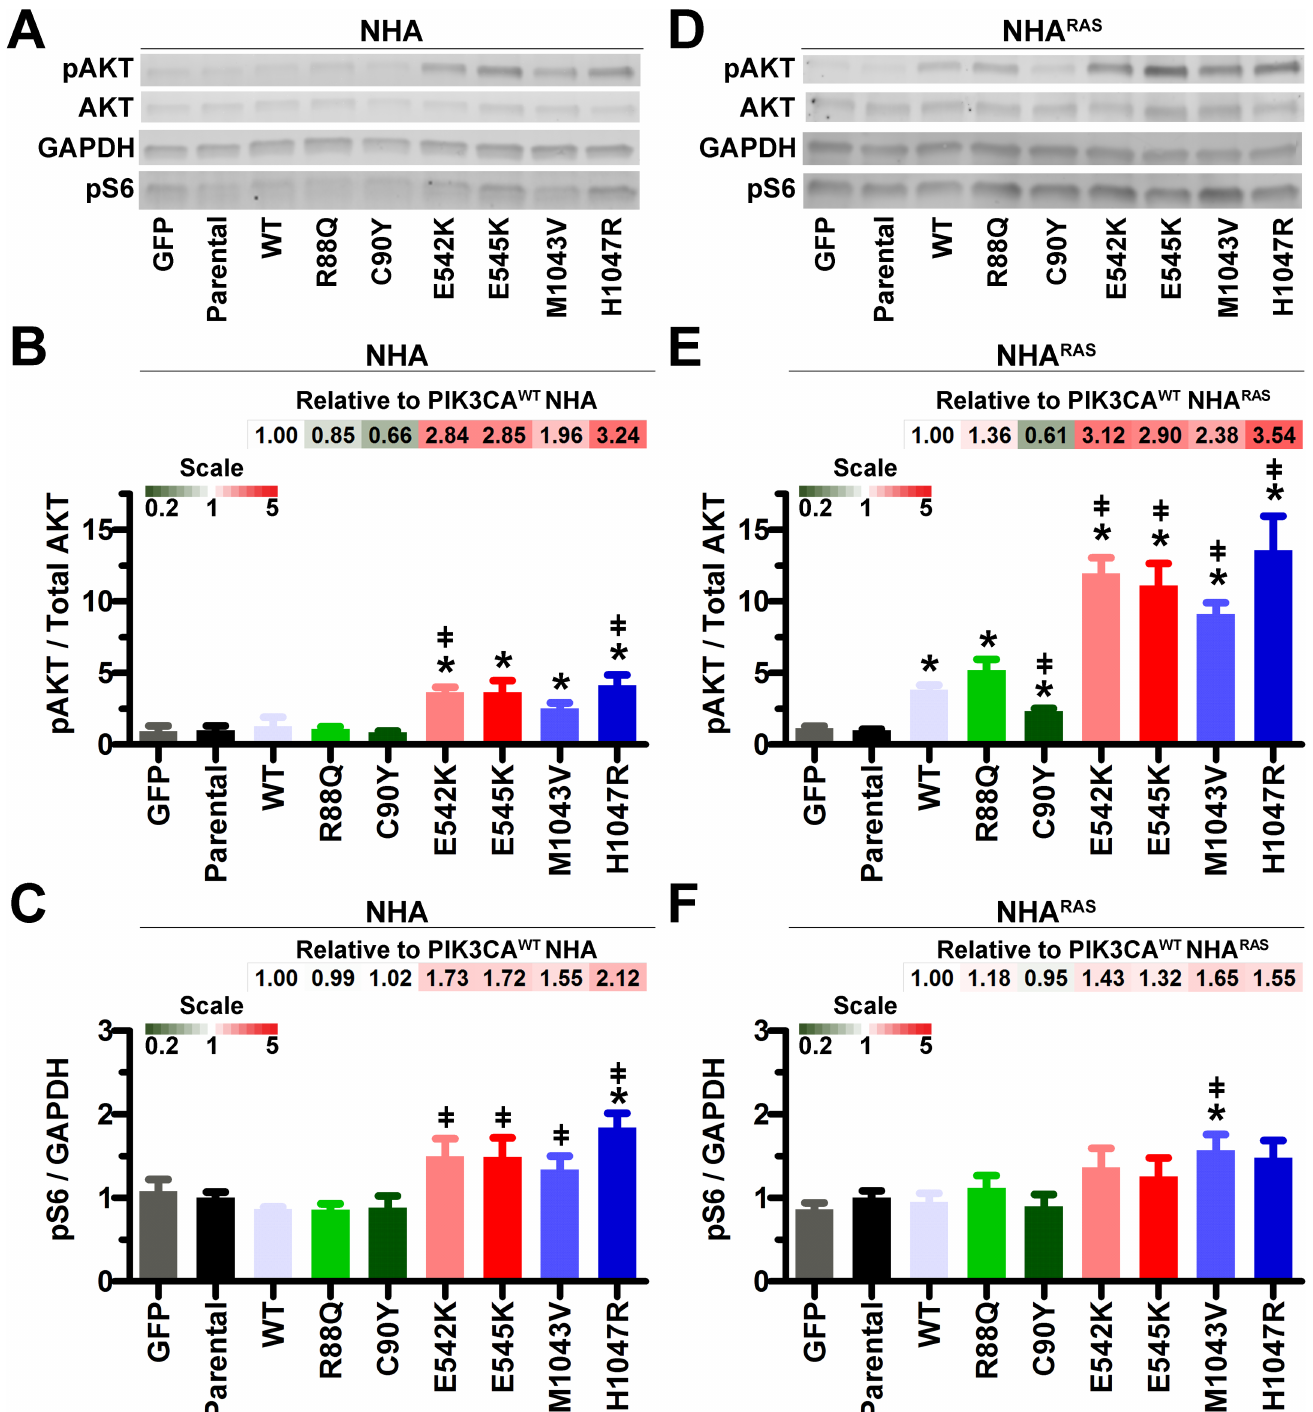
Fig 1. Helical and kinase PIK3CA mut activate proximal PI3K. Representative immunoblots ( A ) and quantification showed that proximal PI3K (pAKT) was increased by helical and kinase mutants in NHA ( B ). Distal PI3K (pS6) was only increased by H1047R ( C ) ( (cid:3) , P (cid:20) 0.02). E542K and H1047R increased proximal PI3K and all helical and kinase mutants increased distal PI3Kcompared to PIK3CA WT NHA (‡, P (cid:20) 0.04). Representative immunoblots ( D ) and quantification showed that proximal PI3K was increased by PIK3CA WT and all mutants ( E ). Helical and kinase mutants also increased proximal PI3K compared to PIK3CA WT NHA RAS (‡, P (cid:20) 0.007). Only M1043V increased distal PI3K compared to parental ( (cid:3) , P = 0.03) and PIK3CA WT (‡, P = 0.03) NHA RAS ( F ). Bar graph data are set relative to parental lines (N = 4 biologic replicates). Fold changes in pAKT and pS6 relative to PIK3CA WT are shown as heatmaps.